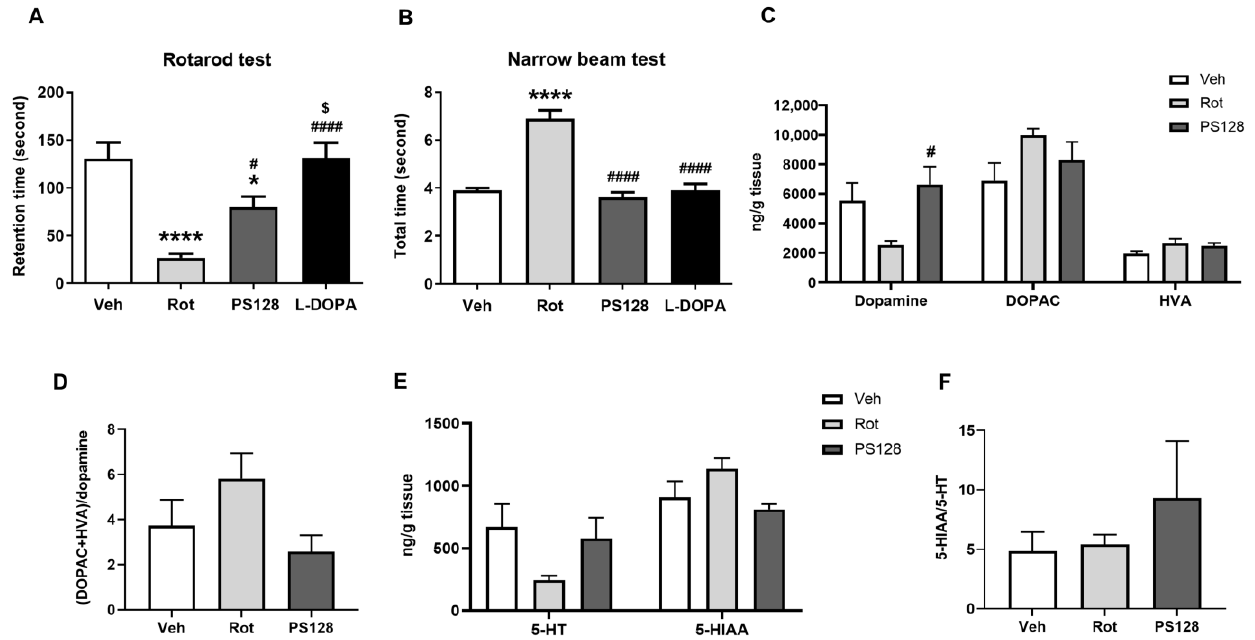
Figure 1. Effects of L. plantarum PS128 on motor deficits and neurotransmitter levels in rotenone- induced PD-like mice. ( A ) Total time spent on the rotarod. ( B ) Total walking time on a narrow beam. ( C ) Levels of striatal dopamine and its metabolites—3,4-dihydroxyphenylacetic acid (DOPAC) and homovanillic acid (HVA). ( D ) The ratio of dopamine turnover. ( E ) Levels of striatal serotonin (5-hydroxytryptamine; 5-HT) and its metabolite—5-hydroxyindoleacetic acid (5-HIAA). ( F ) The ratio of 5-HT turnover. N = 10 per group, * p < 0.05, **** p < 0.0001 compared with the Veh group; # p < 0.05, #### p < 0.0001 compared with the Rot group; $ p < 0.05 compared with the PS128 group.